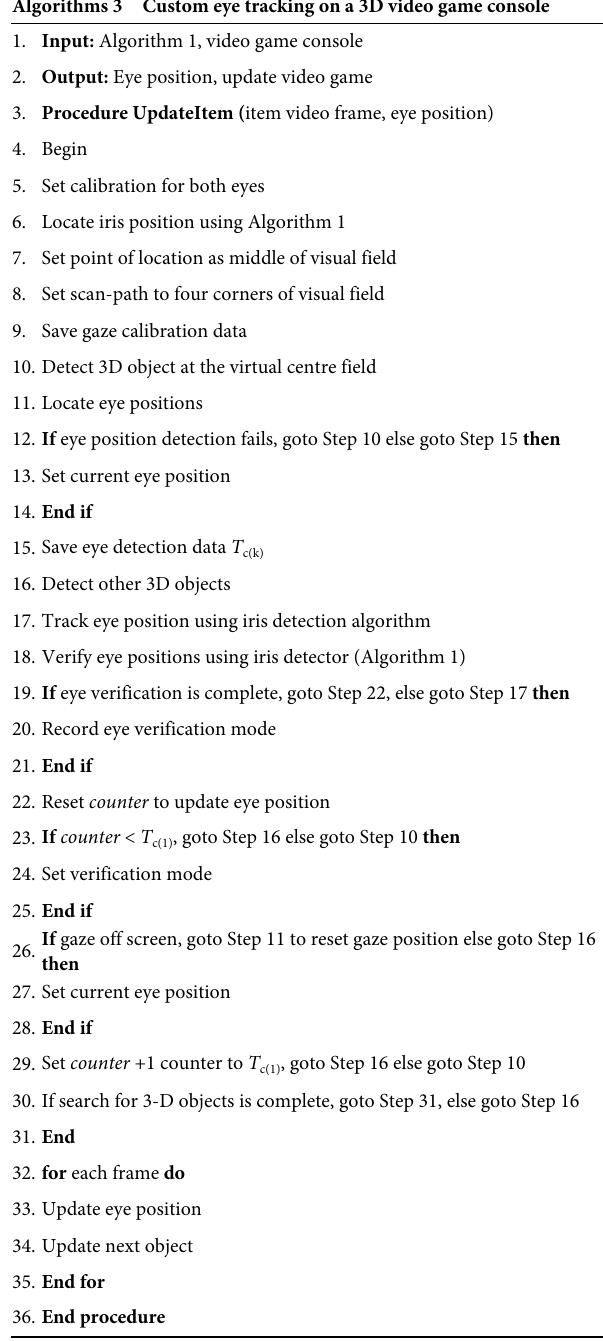
Algorithms 3 Custom eye tracking on a 3D video game